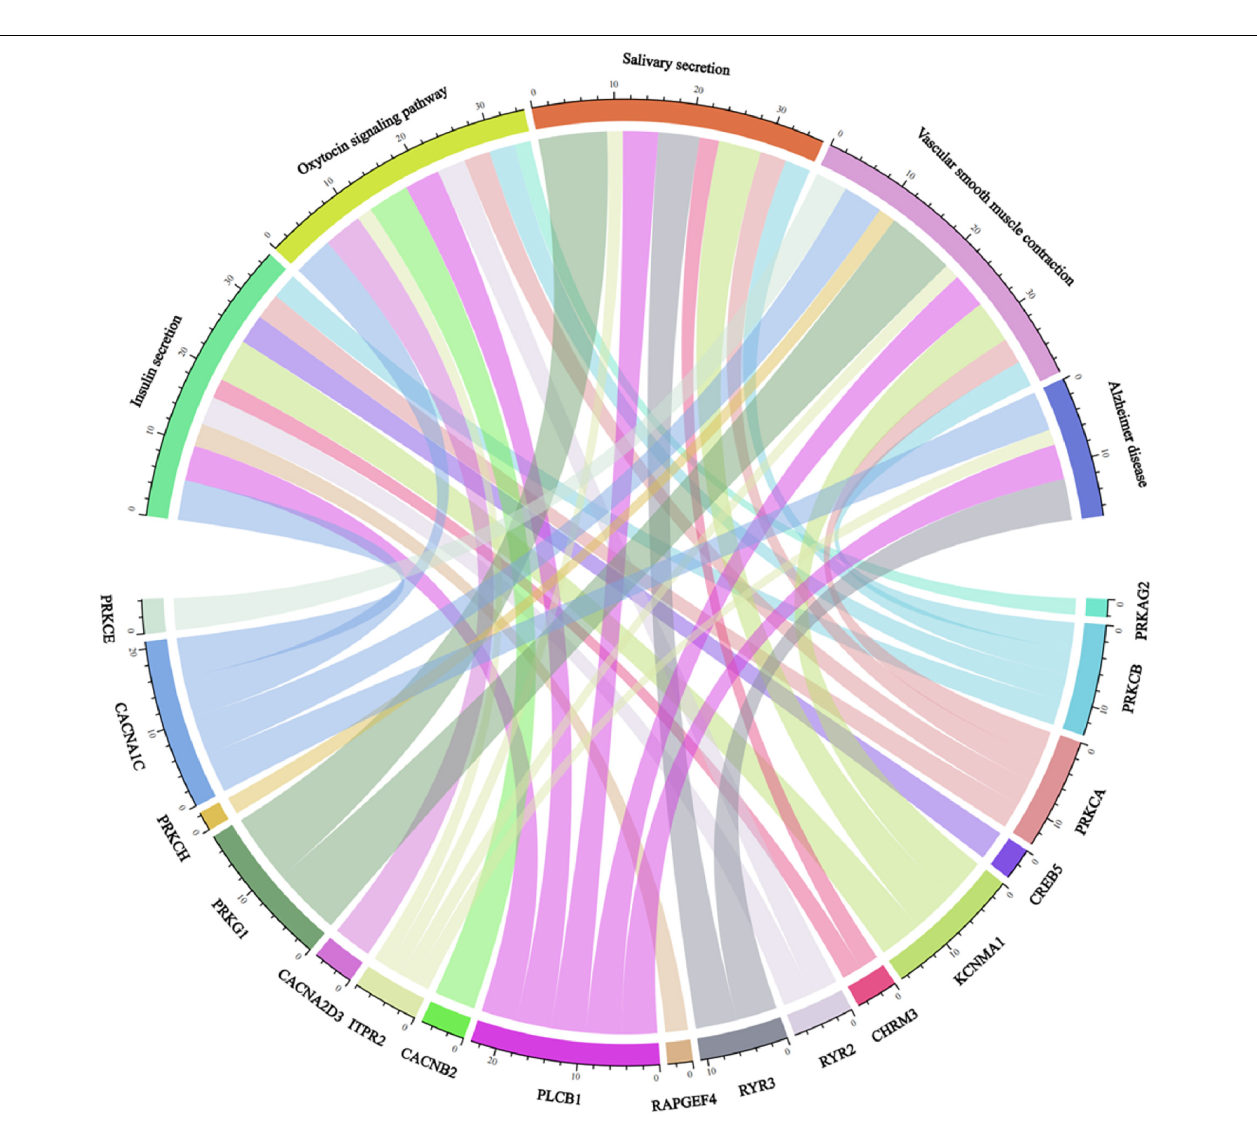
FIGURE 4 | An image showing the relation of genes and